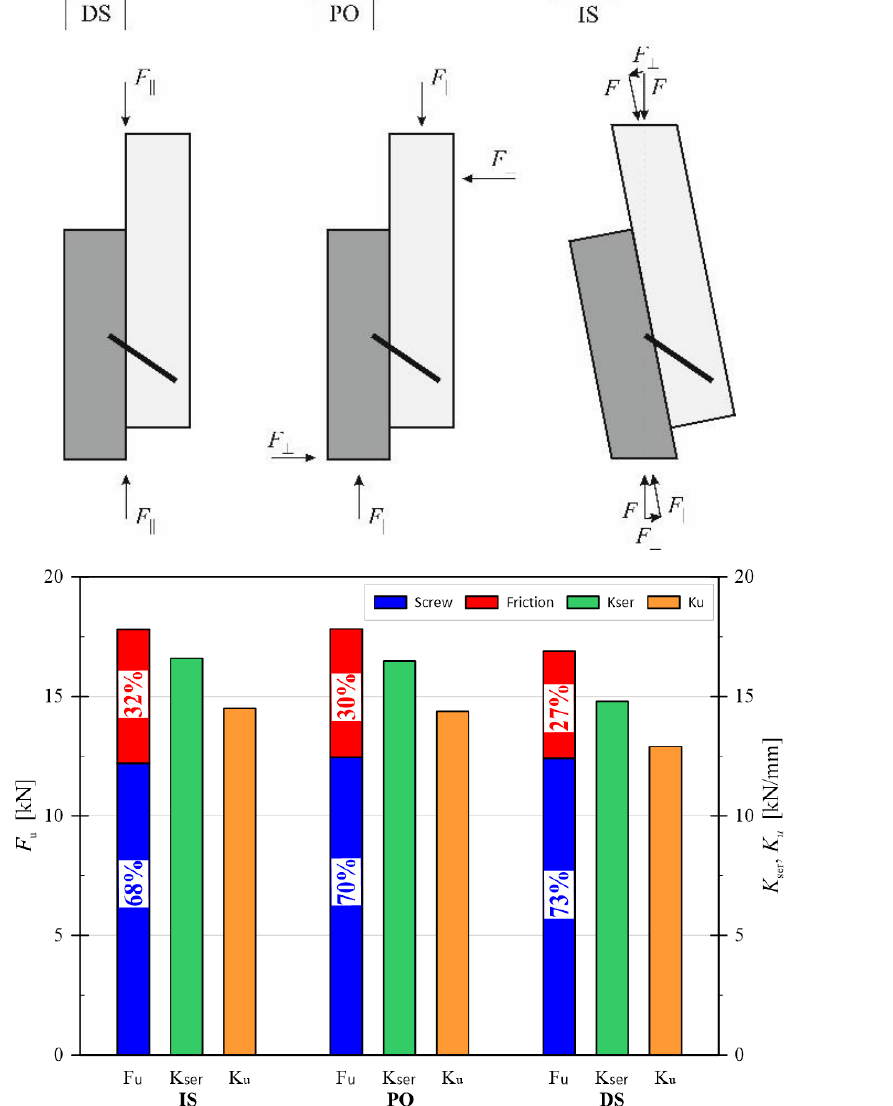
Figure 12. Evidence of ( a ) common test configurations and ( b ) FE numerical estimation of F u , K ser and K u performance indicators. Key: DS = Direct shear; PO = Push-out; IS = inclined shear.